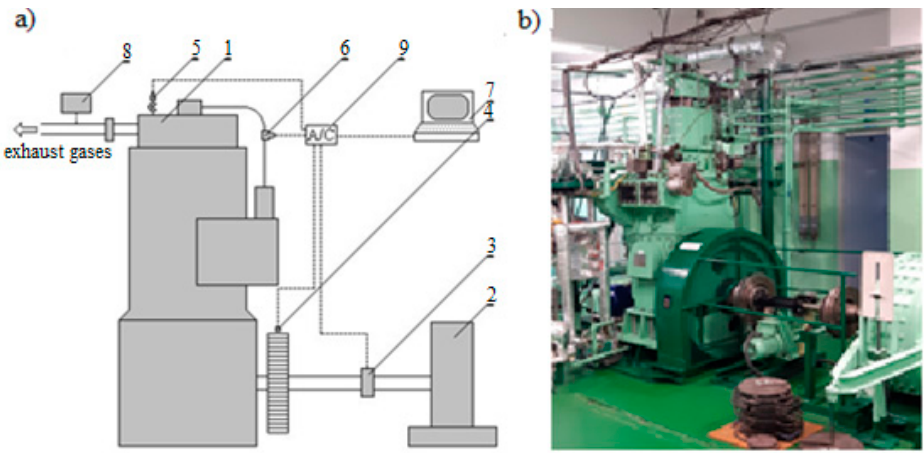
Figure 4. Test stand: ( a ) block diagram: 1—L-22 diesel engine, 2—water brake, 3—torsiometer, 4—gauge for crankshaft position marking and rotational speed measuring, 5—combustion pressure transducer, 6—injection pressure transducer, 7—computer, 8—exhaust gas analyzer, 9—analog / digital converter; ( b ) engine L22-view.